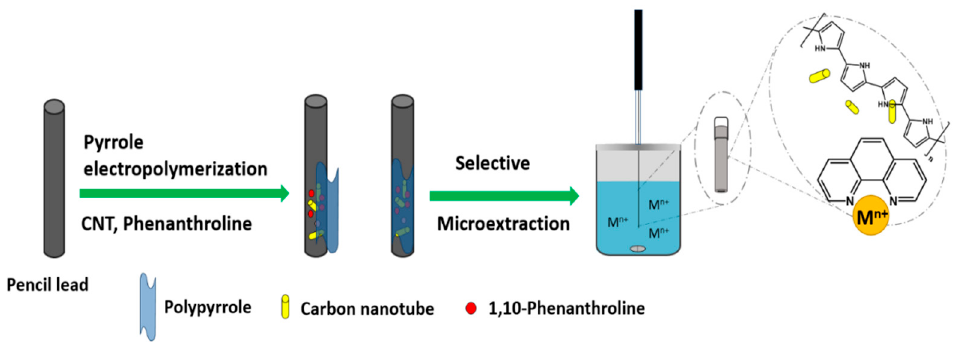
Figure 3. Schematic representation of the creation of an SPME fiber by electropolymerization and its application for metal extraction. Reprinted with permission from [133].